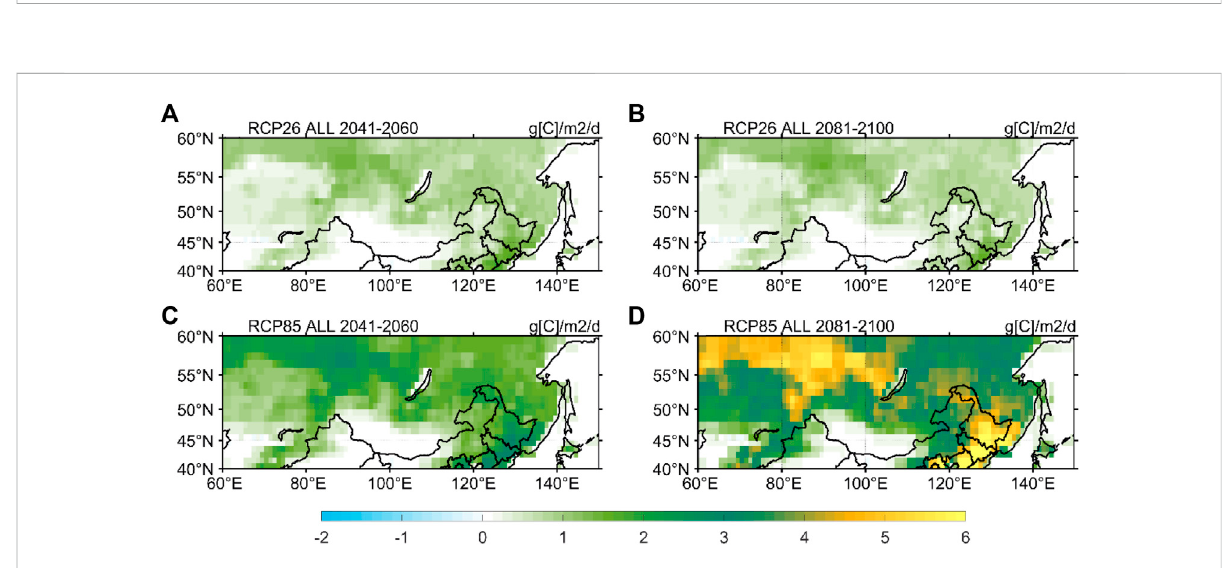
increases by 0.15 gCm -2 d -1 and 0.26 gCm -2 d -1 , respectively.